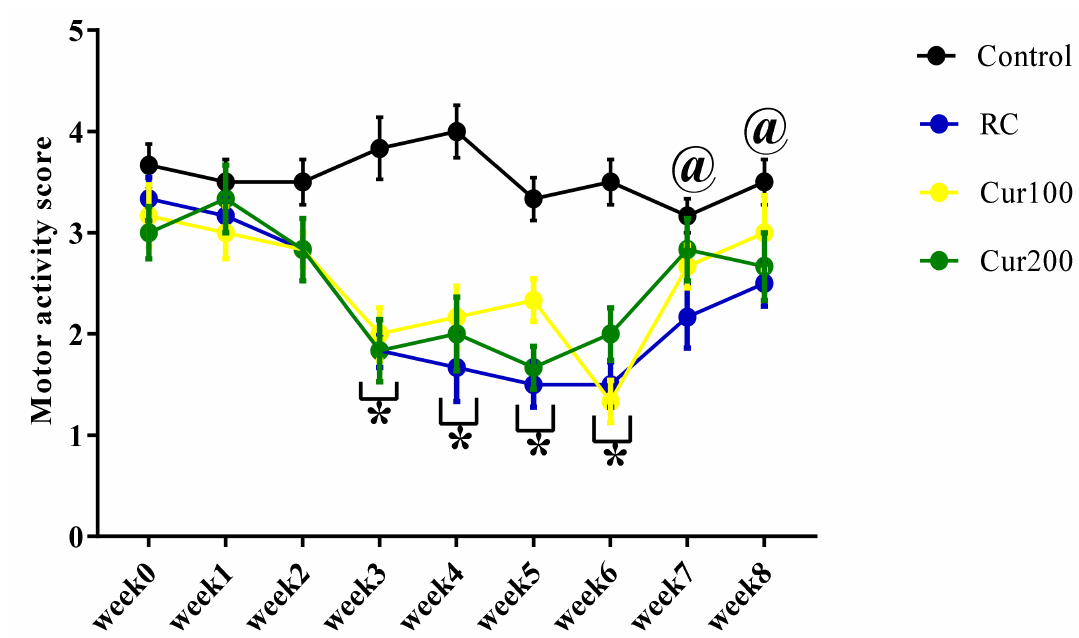
Figure 11. E ff ect of oral admiration of curcumin on Pb-induced rats in the horizontal bar test. Values are presented as mean ± SEM ( n = 6); * p < 0.05 vs. control, @ p < 0.05 vs.